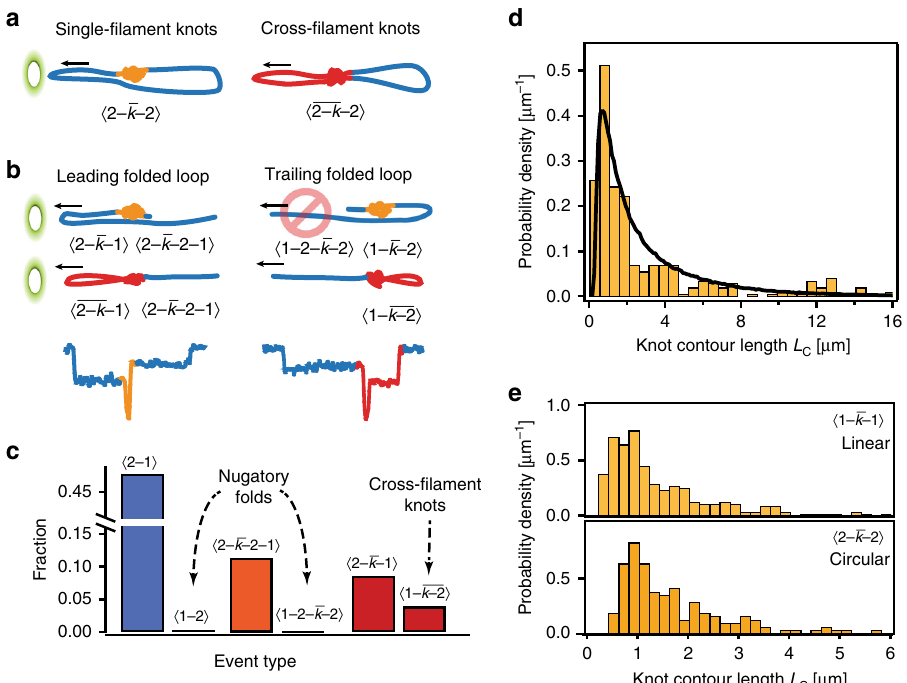
Fig. 4 Two modes of DNA knot translocation and the size distribution of knots. a Distinctive modes of knot translocation in circular DNA; a single- fi lament knot resides on one strand of the translocating DNA, cross- fi lament knot straddles over two translocating fi laments, experiencing signi fi cantly lower tension force. b Single- fi lament and cross- fi lament knots in translocating linear DNAs with leading (left) and trailing folded loops (right). c Proportions of knotted events in different con fi gurations, where high relative prevalence of h 1 (cid:4) k (cid:4) 2 i knots demonstrates the existence of cross- fi lament mode of translocation. d Histogram of the measured knot contour lengths shows coexistence of both tight and loose knots. Black curve represents simulated distribution of knot sizes for DNA population with w DNA = 2.5 nm. e Histograms of knot sizes for linear DNA (top) and circular DNA (bottom) shows very similar distribution, despite different modes of translocation, indicating lack of knot-tightening in our experiments. Source Data are provided as a Source Data fi